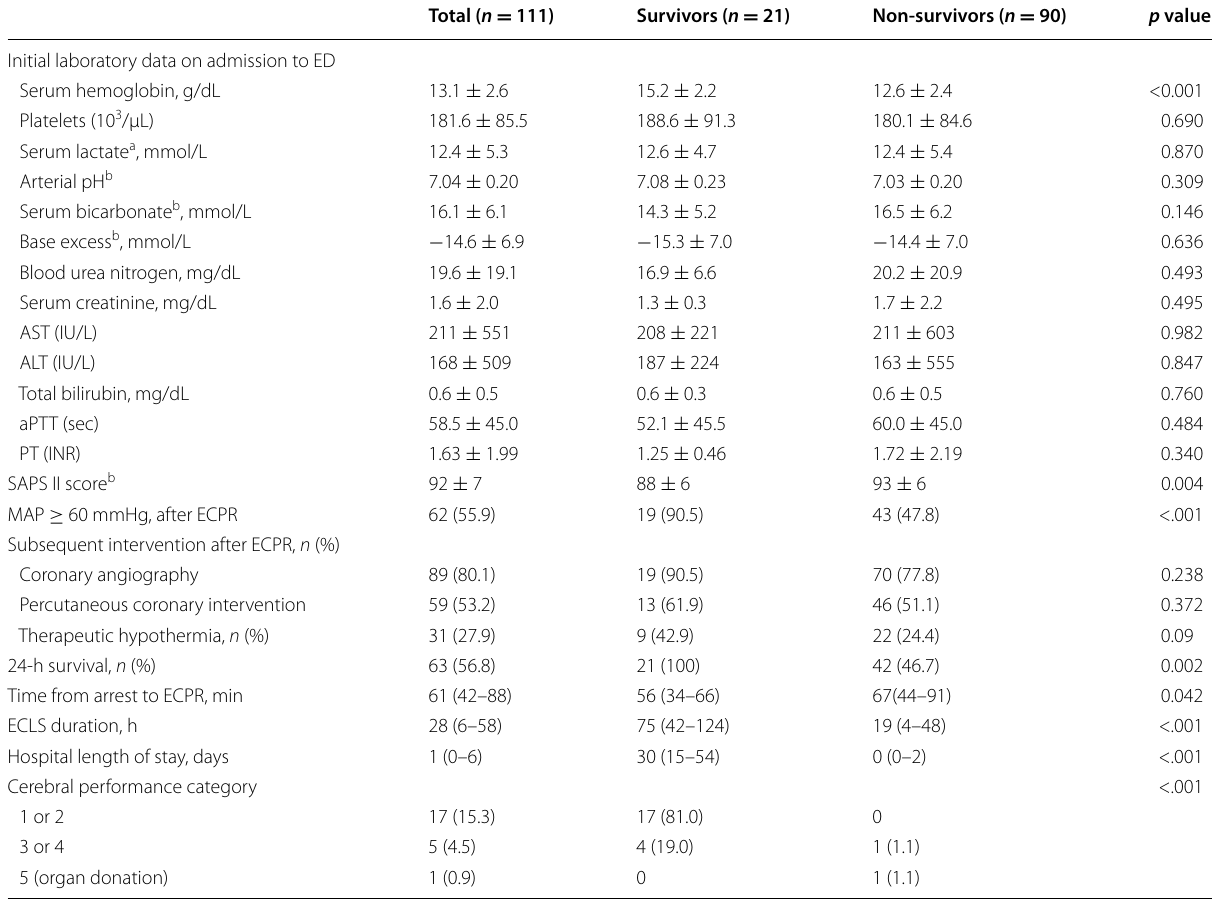
Table 2 Post-resuscitation care and